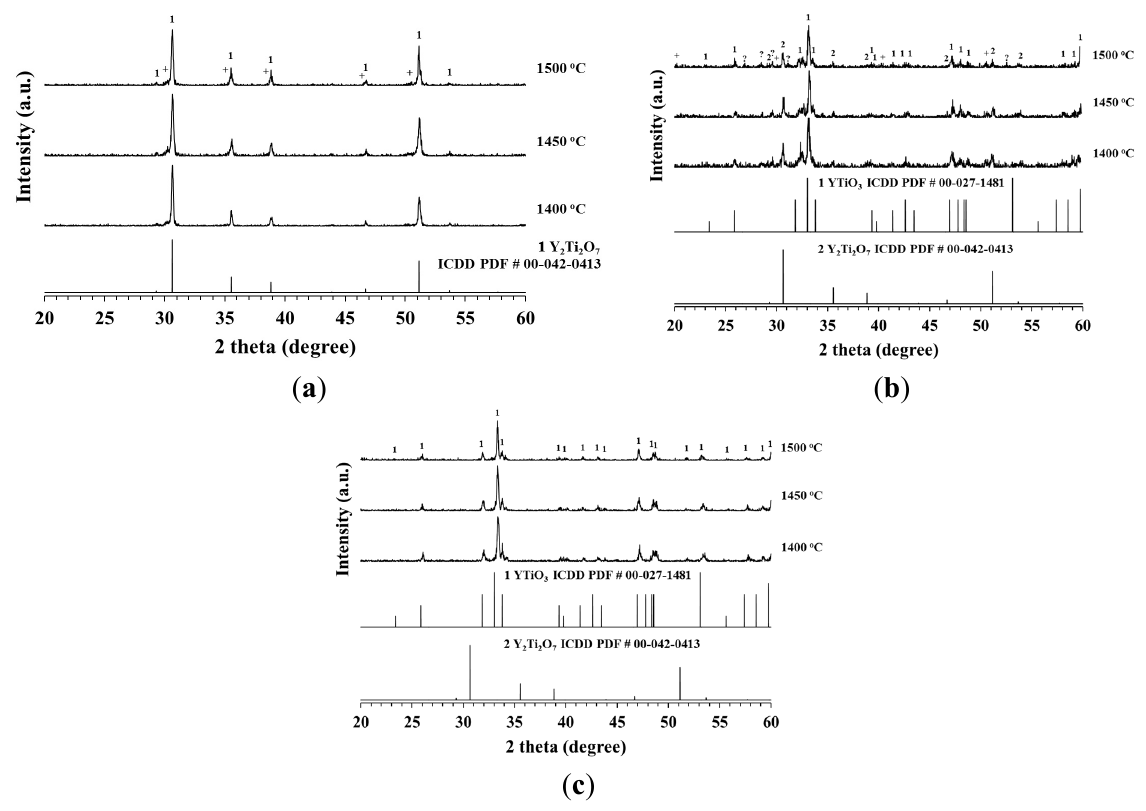
Figure 1. XRD patterns of the 2 h sintered ( a ) YTiO 3 (YT); ( b ) Y 0.6 Ca 0.4 Ti 0.6 Mn 0.4 O 3 − (YCTM4); ( c ) Y 0.6 Ca 0.4 Ti 0.4 Mn 0.6 O 3 − (YCTM6) ceramics. +: YTiO 2.085 ; ?: unknown phases. 